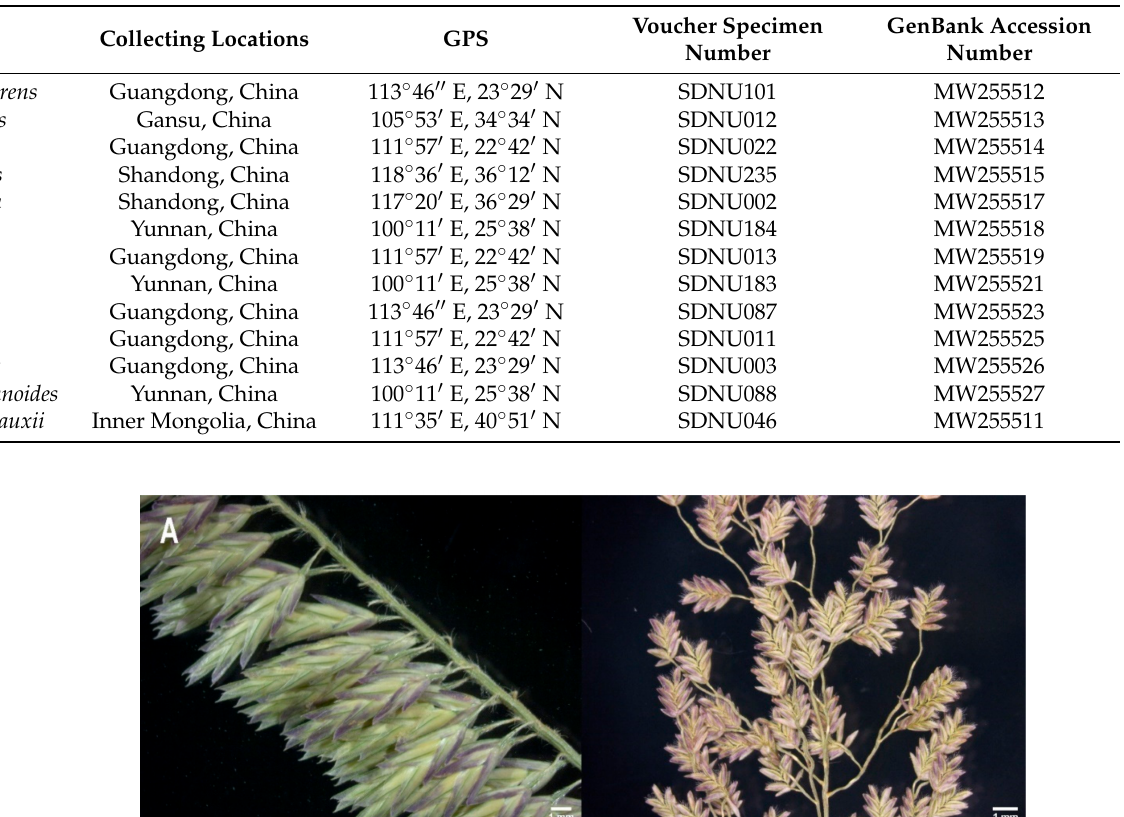
Table 1. Voucher specimen information of newly sequenced 13 Eragrostideae species.